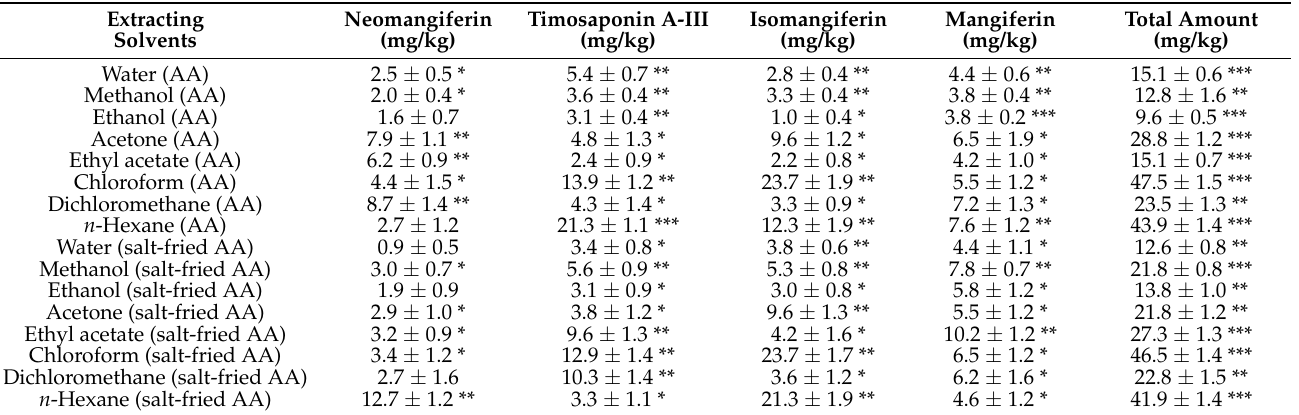
salt-fried Anemarrhena asphodeloides .